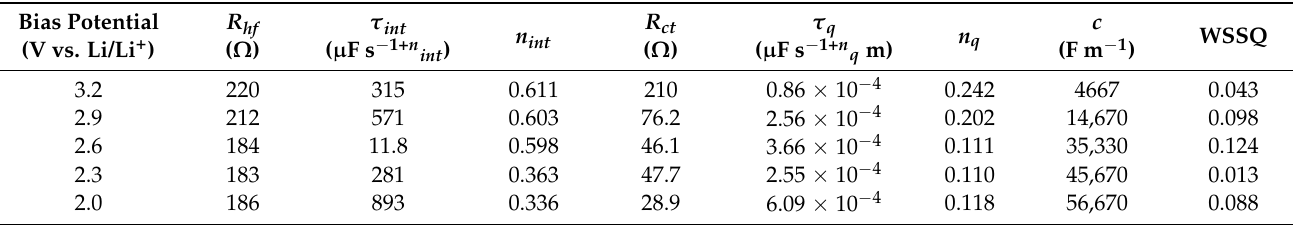
Table A1. Parameters obtained from fitting of experimental EIS spectra shown in Figure 3a,b and Figure 4a to the equivalent circuit depicted in Figure 1a. In addition, the weighted sum of squares (WSSQ) value of each fit is presented. Resistance and capacitance values were normalized to 1 cm 2 of electrode area.